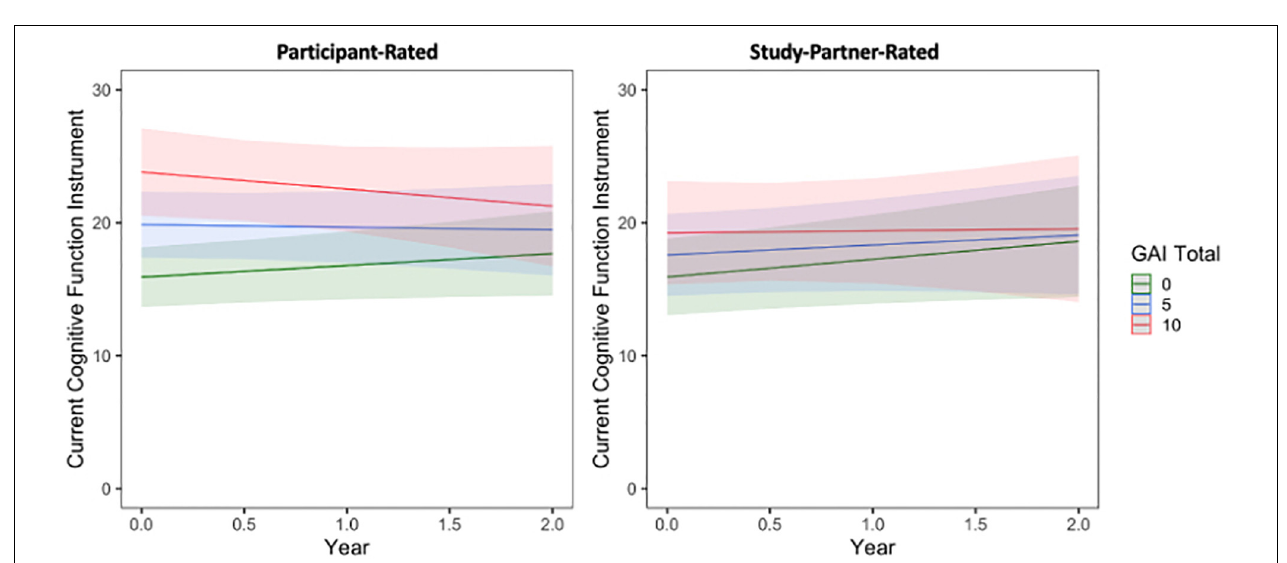
FIGURE 2 | The interaction between baseline participant GDS score and time to predict participant-rated (left) and study partner-rated (right) cognitive concerns using the current CFI. A significant interaction was seen between GDS and time when predicting participant-rated cognitive concerns (fixed estimate = –0.17, adj. p = 0.0012), in that participant concerns decreased over time in participants with higher GDS score at baseline (indicative of greater depressive symptomatology). The interaction between GDS score and time predicting study partner-rated cognitive concerns was not significant (fixed estimate = –0.003, adj. p = 0.964).